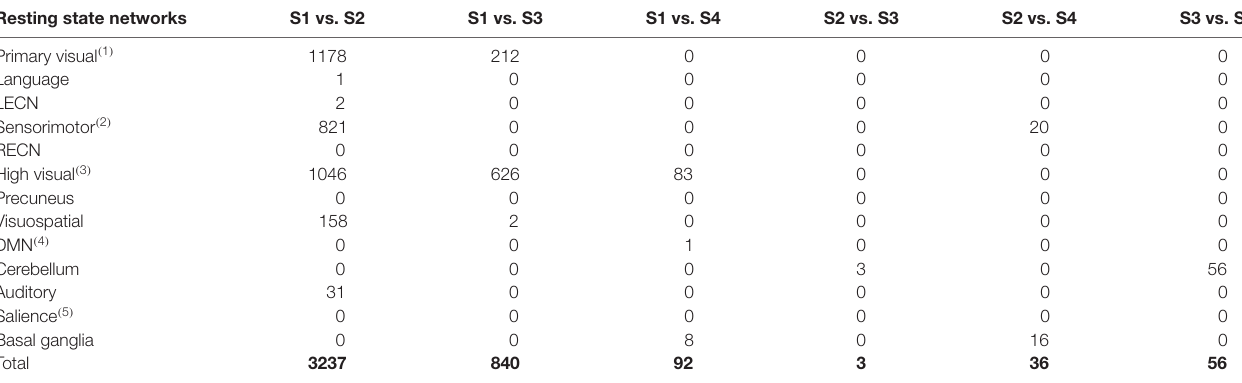
TABLE 4 | Voxel count for no-correction dual regression analyses. Resting state